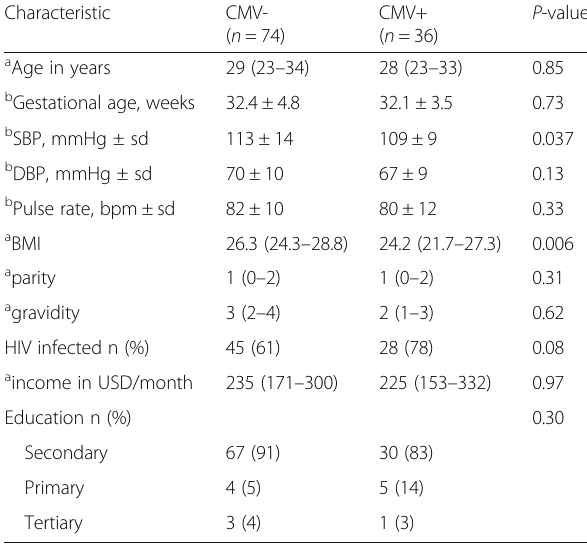
Table 2 Participants ’ demographic and clinical